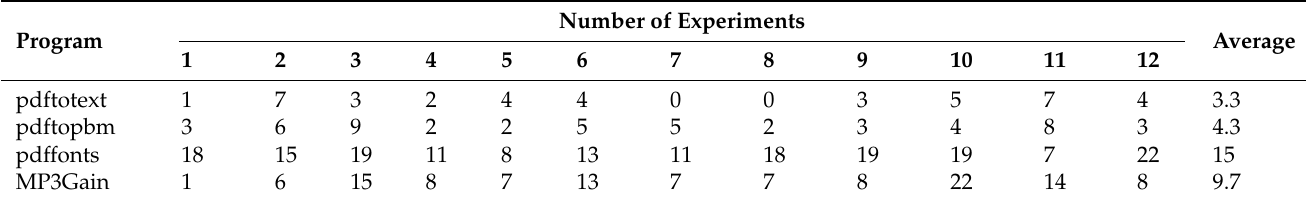
Figure 3. Proportion of newly discovered unique crashes in the exploration stage of R E F UZZ . Table 8. Number of new unique crashes (80 +